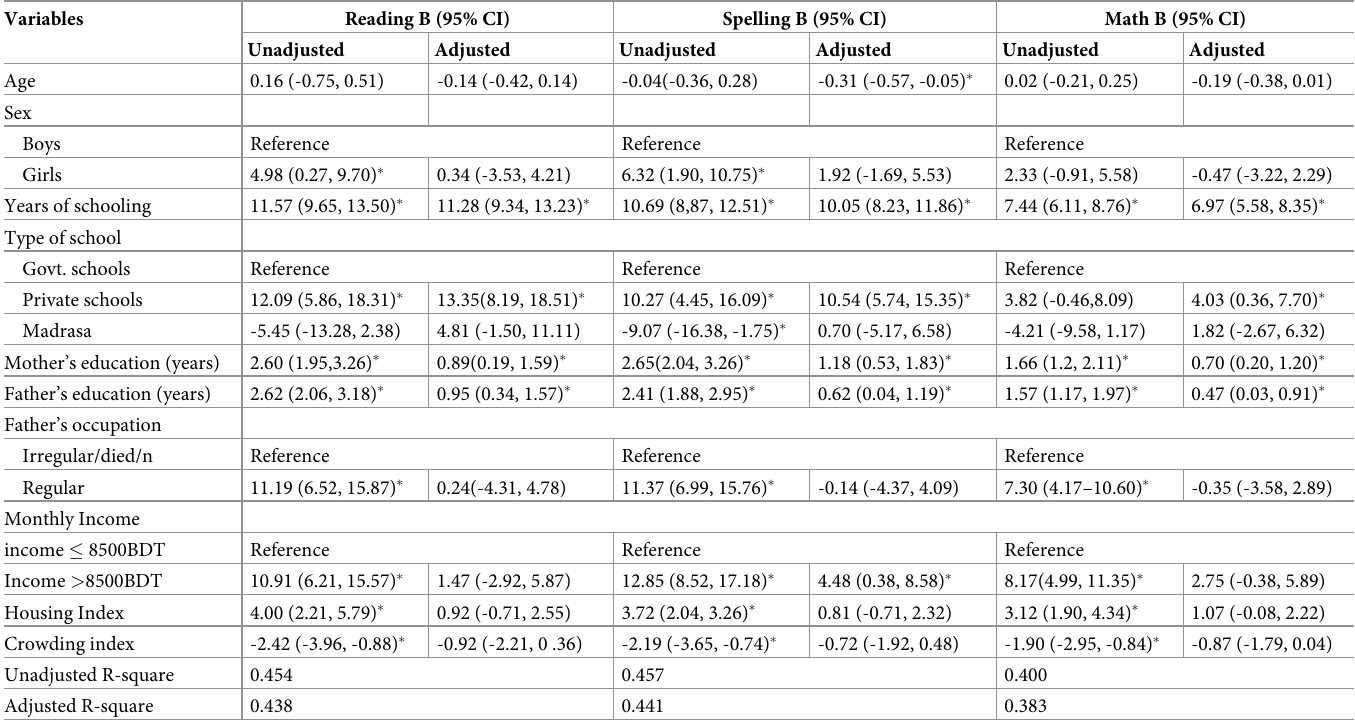
Table 2. Unadjusted and adjusted multiple linear regression analysis of the background characteristics on school achievement